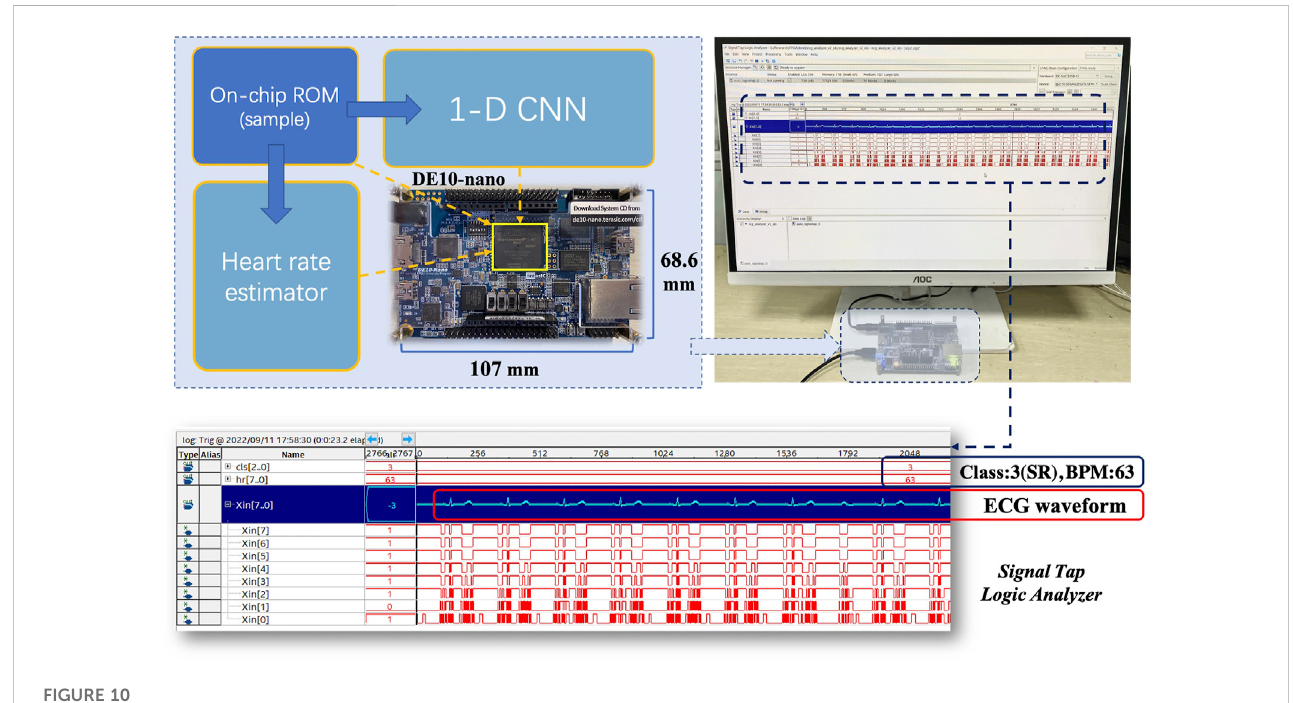
FIGURE 10 Test on DE10-nano development